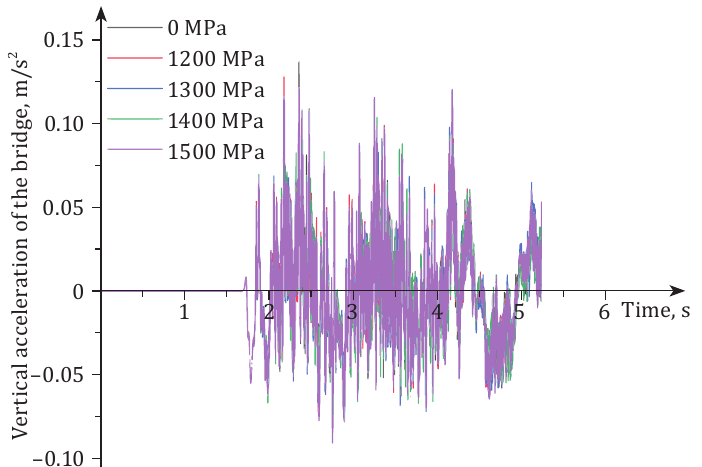
Figure 15. Comparison of vertical acceleration time